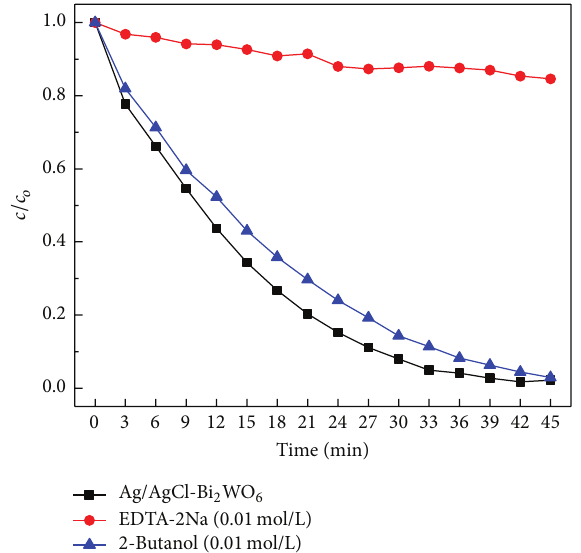
Figure 12: Photocatalytic activity in presence of Ag/AgCl/-Bi 2 WO 6 and quenchers.